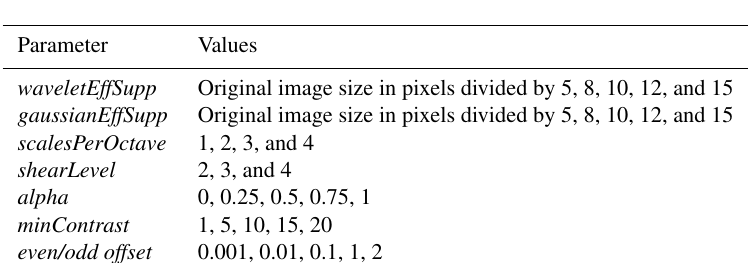
Figure 5. Effect of multiple ridge realizations on a sample image from Parmelan anticline, France (Prabhakaran et al., 2019b). (a) Base case image used for testing the effect of multiple ridge realizations. (b) Ridge map obtained using the base case shearlet parameters in Table 3. (c) Overlay of ridges obtained using base case shearlet parameters over the test image. (d) Normalized ridge intensity ensemble map obtained after 1050 ridge realizations using the parameters in Table 4. (e) Threshold ridge intensity map that enhances features. (f) Overlay of ridges using the threshold ridge intensities over the test image. Table 4. Ensemble for parameter